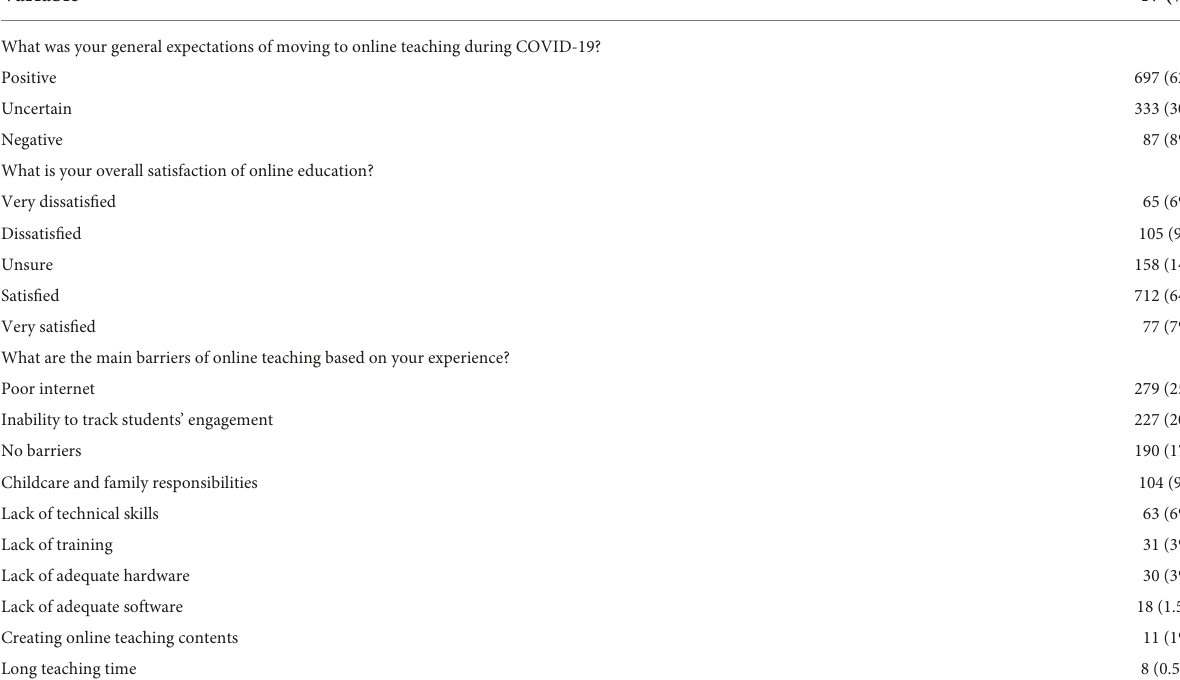
TABLE 4 Expectations, satisfaction, and barriers of online teaching during COVID-19.